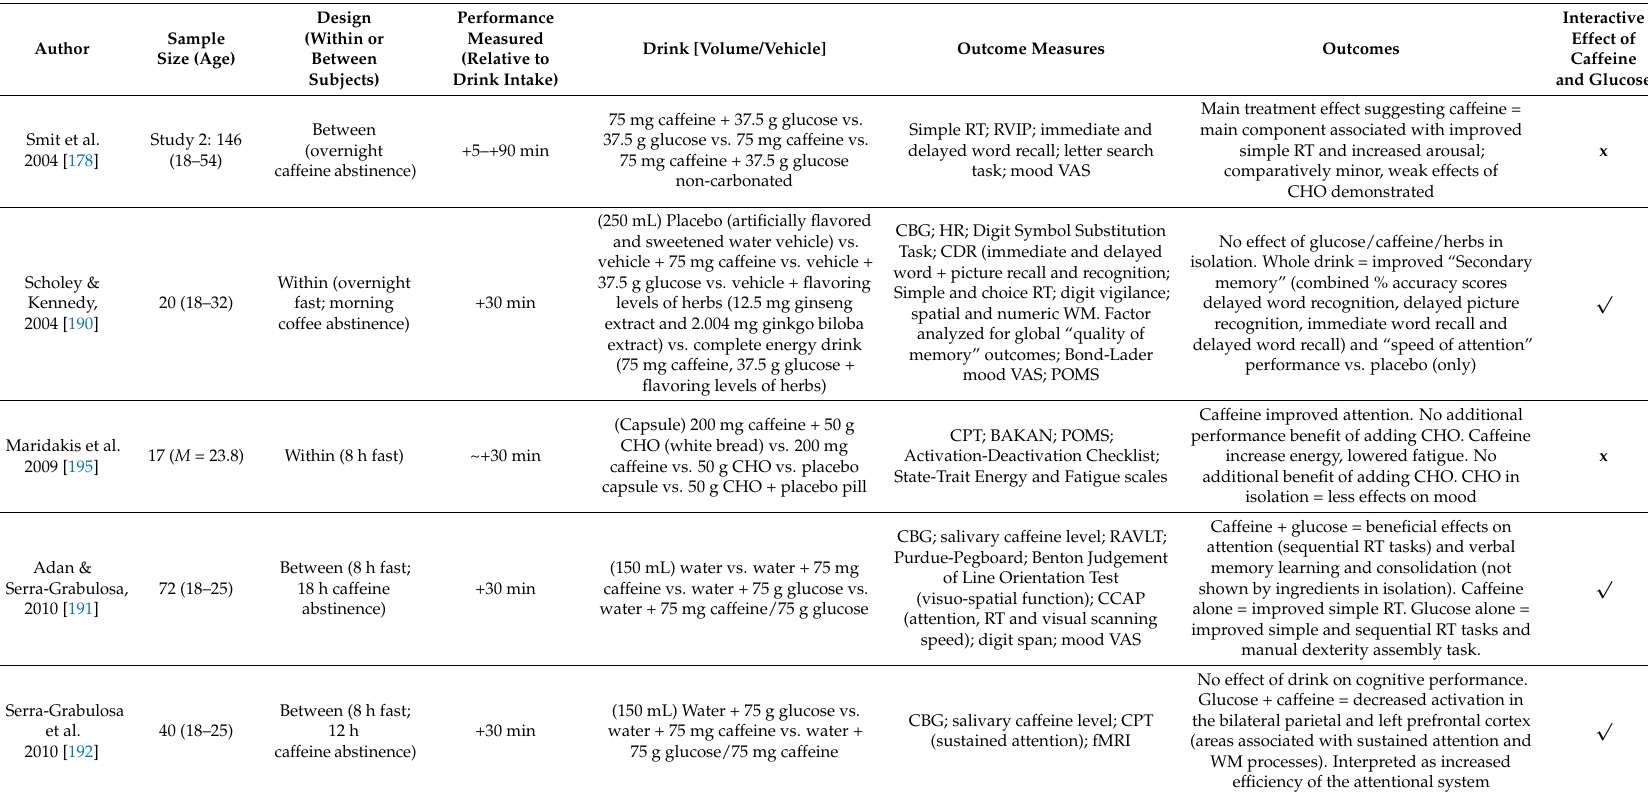
Table 6. Summary of studies examining the effects of caffeine and CHO in combination and isolation on cognitive performance and subjective